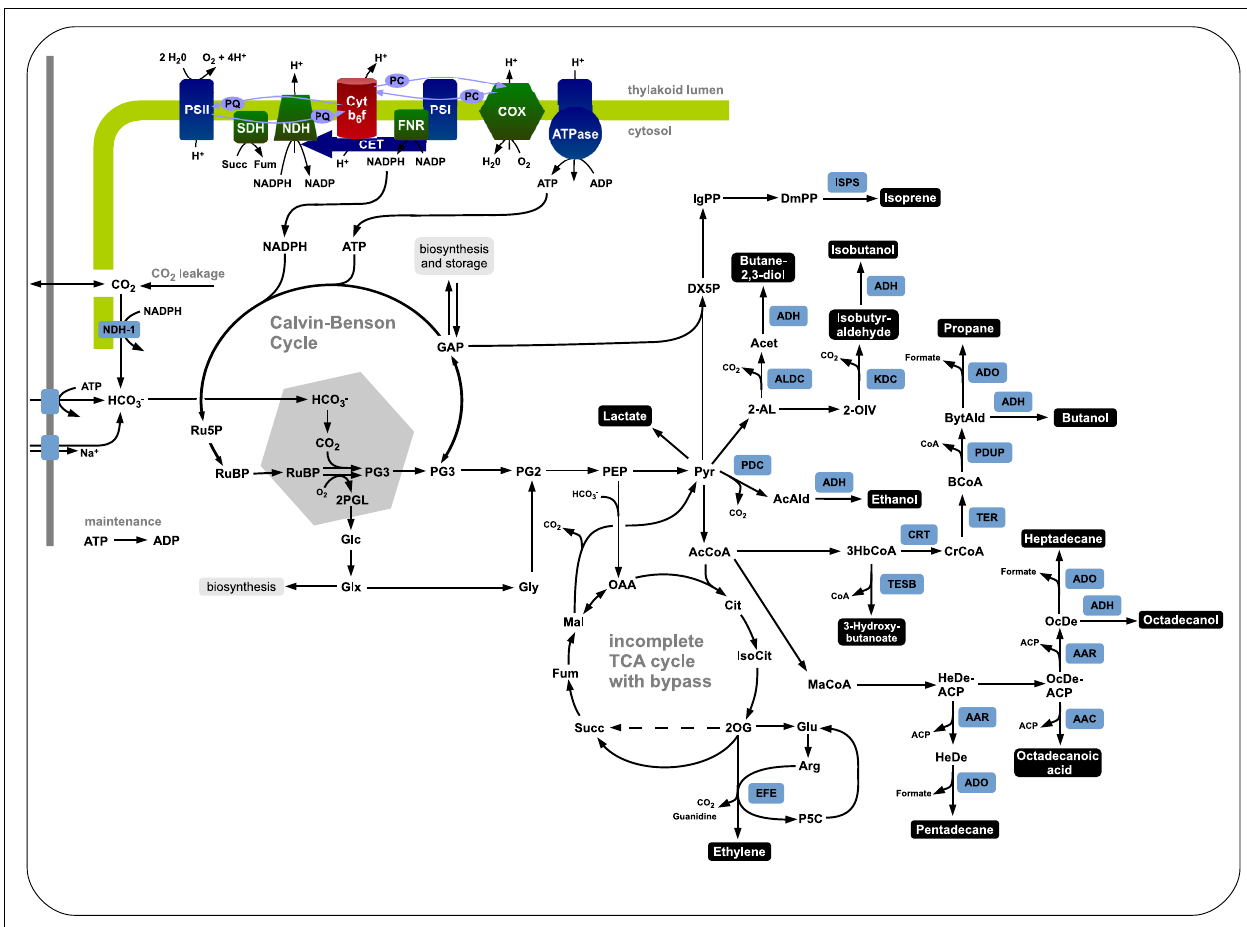
precursor for product synthesis. Shown are key pathways toward ethanol, lactate, isoprene, ethylene, butane-2,3-diol, isobutanol, isobutyraldehyde, butanol, propane, 3-hydroxybutyrate, heptadecane, octadecanol, octadecanoic acid, and